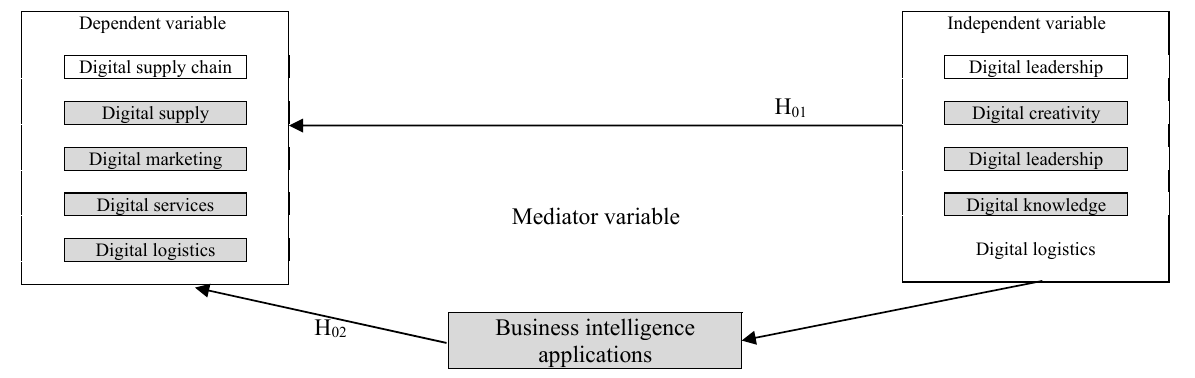
Fig. 1. The proposed study (Al-Tarawneh & Shalash, 2015; Nsour, 2020; Al-Barashdiya et al., 2021;